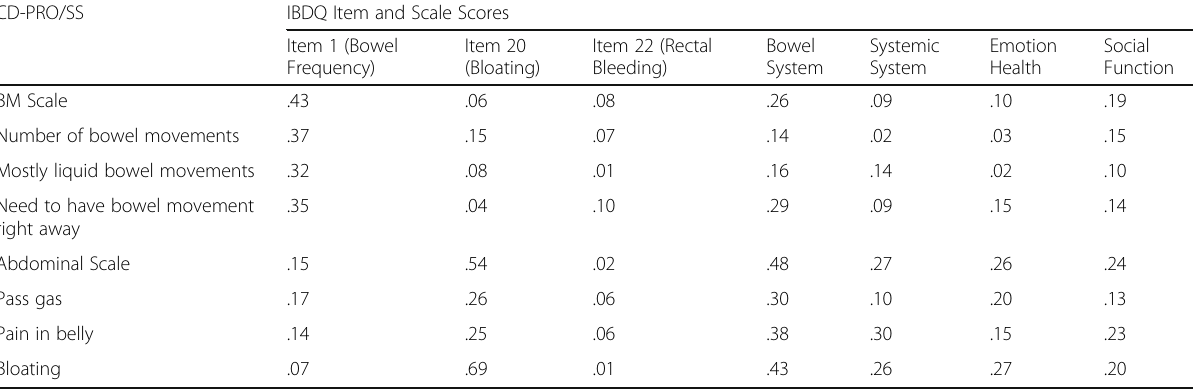
Table 3 Construct Validity: CD-PRO/SS Score Correlations a with IBDQ Scores at Baseline